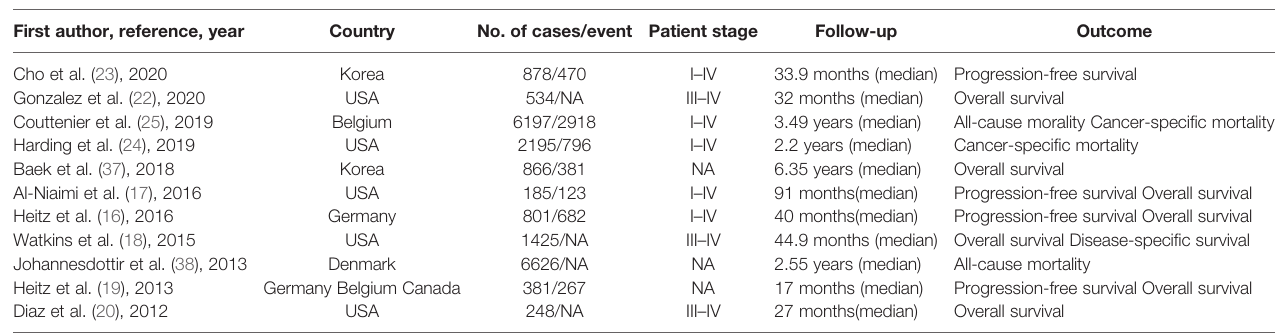
TABLE 1 | Characteristics of included